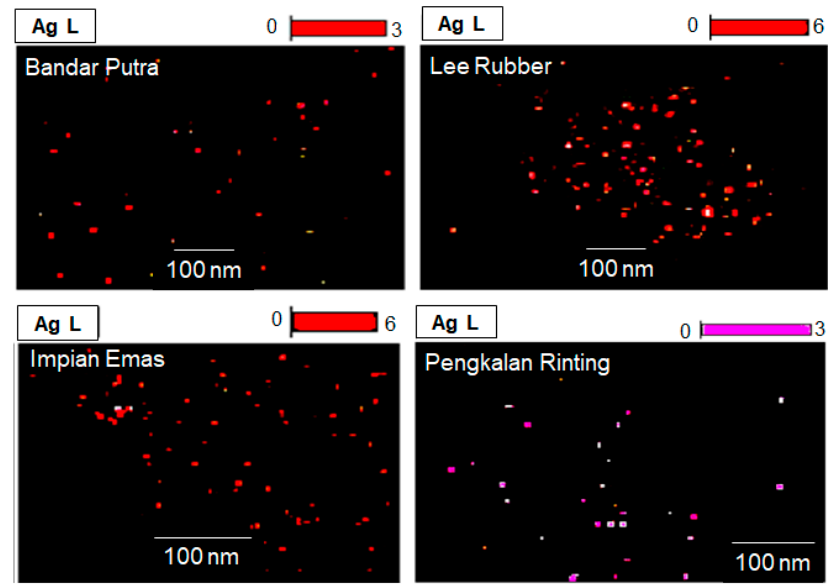
Figure 4. Elemental mapping of Ag by EDX.